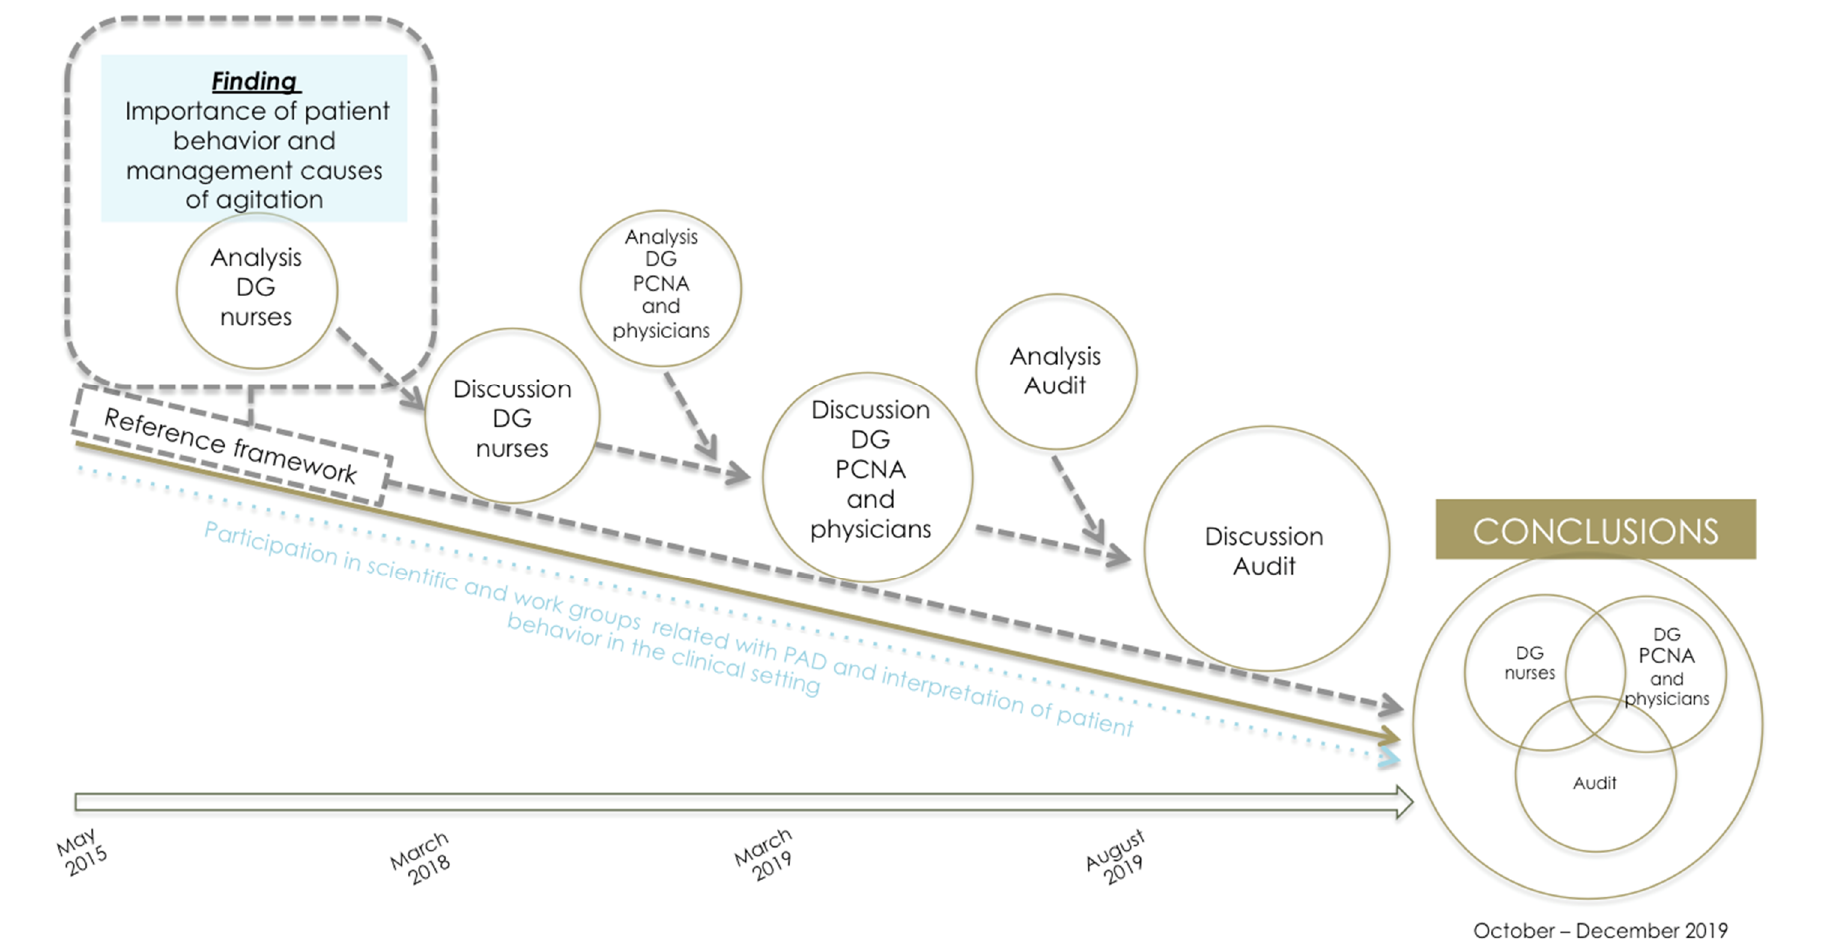
Figure 6. Cumulative discussion: integration of discussions of the different components via the “snowball effect”. Abbreviations: PCNA: patient care nursing assistants; DG: discussion group; PAD: pain/agitation-sedation/delirium.